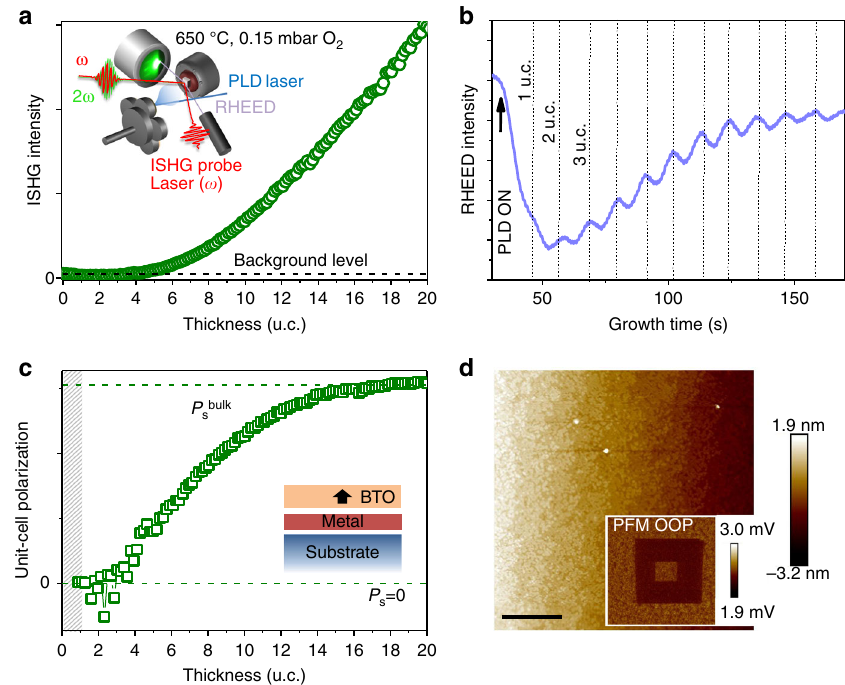
Fig. 1 Emergence of polarization in ultrathin tetragonal BaTiO 3 fi lms at 650 °C. a In situ second harmonic generation (ISHG) intensity dependence of BaTiO 3 (BTO) fi lm thickness during the pulsed laser deposition growth of epitaxial BaTiO 3 | SrRuO 3 || SrTiO 3 . The dashed line indicates the intensity of the surface-induced background ISHG signal on the order of 1%. A schematic of the ISHG setup is shown as inset. b Re fl ection high energy electron diffraction (RHEED) measured in parallel to the ISHG yield. c Unit-cell (u.c.) polarization as a function of thickness derived by deconvolution from the background ISHG signal (Methods section) and normalization of the square root of the remaining polarization-related ISHG intensity to the fi lm thickness. Data below 1 u.c. are not plotted due to artifacts resulting from the normalization of zero-signal noise. In the inset, the arrow indicates the polarization direction of the BTO single-domain fi lm. d Topography and out-of-plane piezoresponse force microscopy scan (PFM OOP) of a BTO fi lm of 30 u.c. that was tip-voltage- poled in a quadratic box-in-box region (see inset). b , d Do not reveal any evidence for probe-laser damage to the fi lm surface, laser-induced polarization switching or changes in the ferroelectric poling behavior. The scale bar corresponds to 1 µ